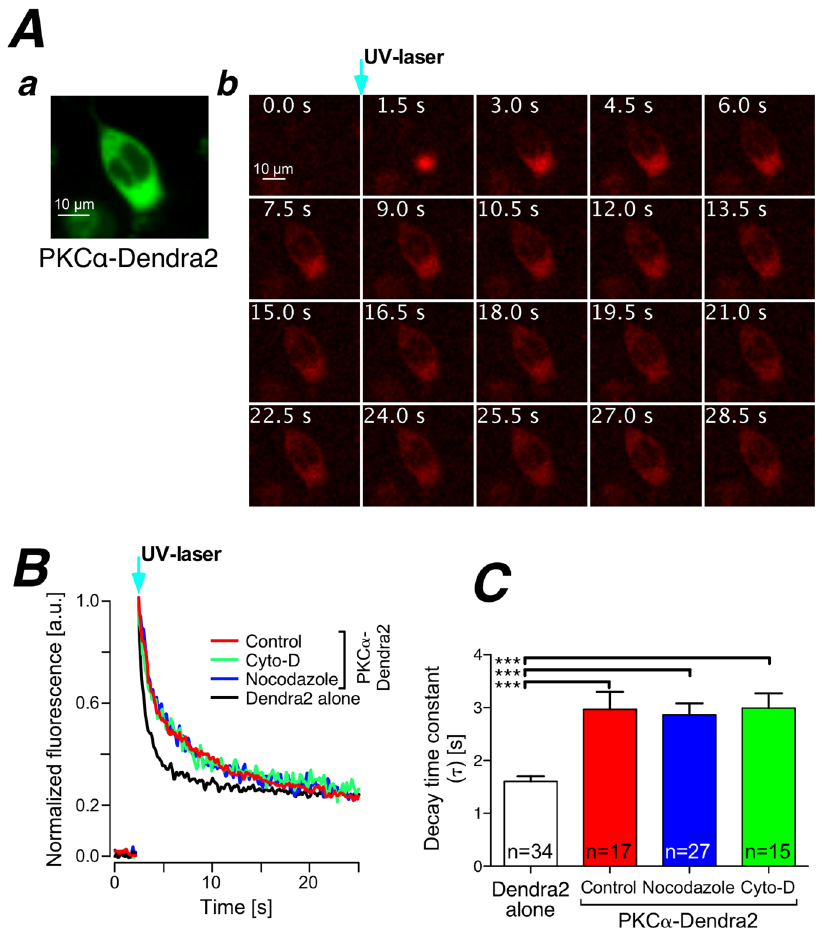
Figure 5. Cytosolic PKC α mobility is not modulated by the state of the cytoskeleton under resting conditions. ( A ) Photoconversion of PKC α -Dendra2 by spatially restricted illumination with a focused UV-laser. Inset shows green fluorescence of Dendra2 under resting conditions. The sequence of images depicts the time course of the red PKC α -Dendra2 fluorescence following UV illumination. Time points are given in each image. ( B ) Fluorescence time course at the point of photoconversion under various experimental conditions (given in the inset). ( C ) Statistical summary of the fluorescence decay at the point of photoconversion during the experimental conditions given. Numbers given on the bars indicate number of cells in at least 3 independent